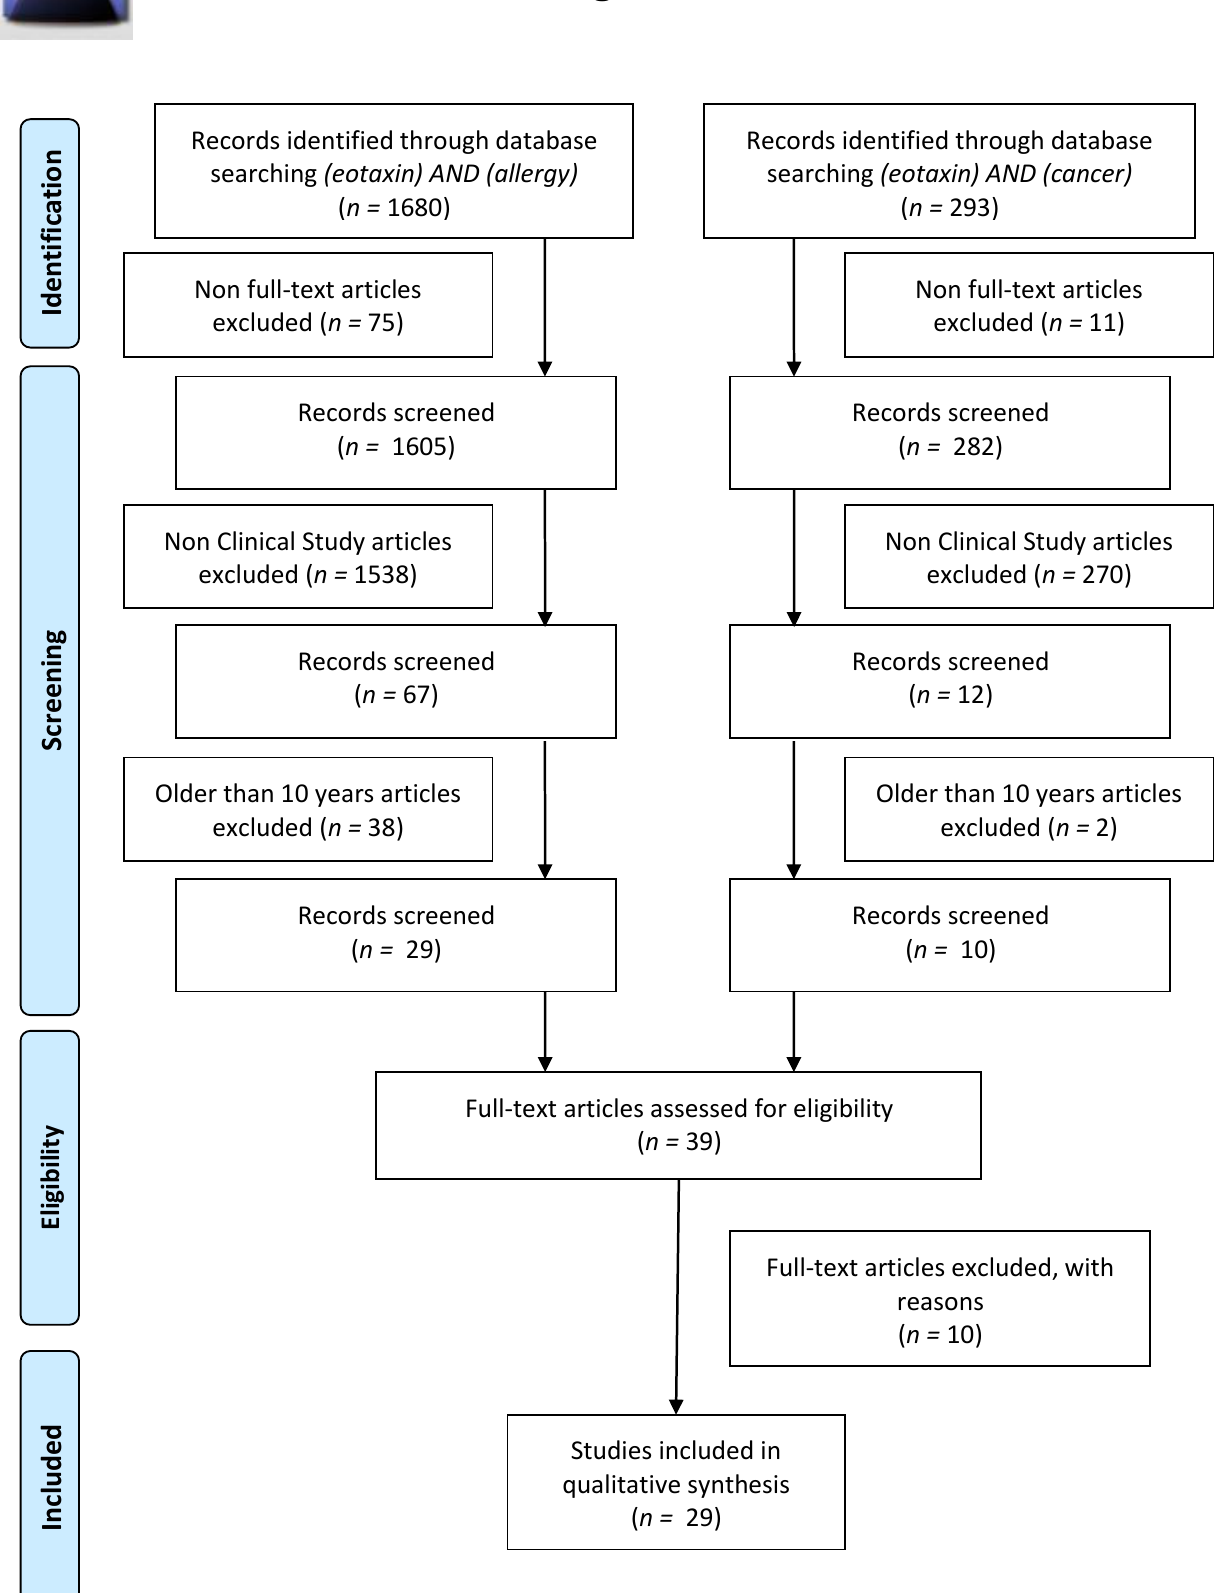
Figure 1. Schematic illustration of articles included in the review manuscript.